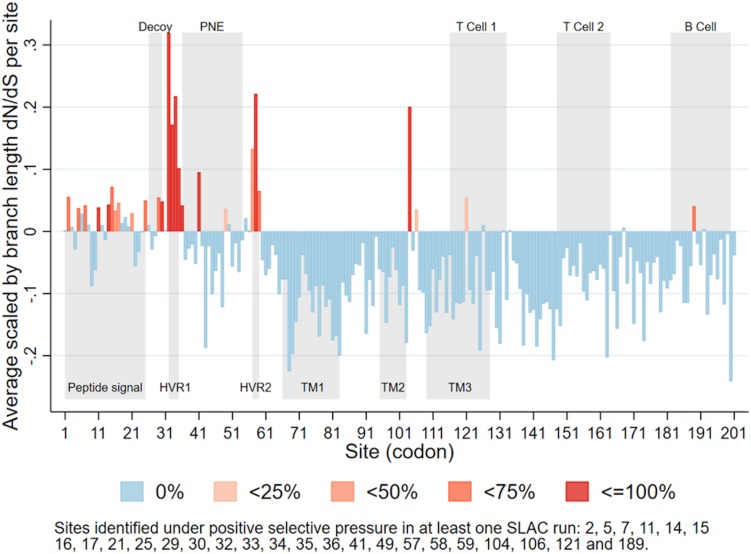
Average scaled by branch length dN/dS for each site in PRRSV ORF5, categorized according to percentage of runs (n = 10) in which each site was identified as under positive selective pressure. Upper gray rectangles show antigenic regions (PNE – principal neutralizing epitope), lower gray rectangles show biologically significant regions (HVR – hypervariable region; TM – transmembrane region) (Delisle et al., 2012).